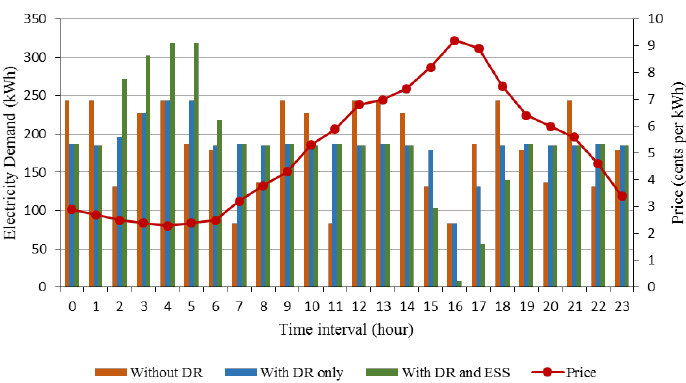
Figure 14. Total electricity demand (within the interaction of the ESS) for three test cases during each time interval: ( a ) without DR; ( b ) with DR only; and ( c ) with DR and ESS.